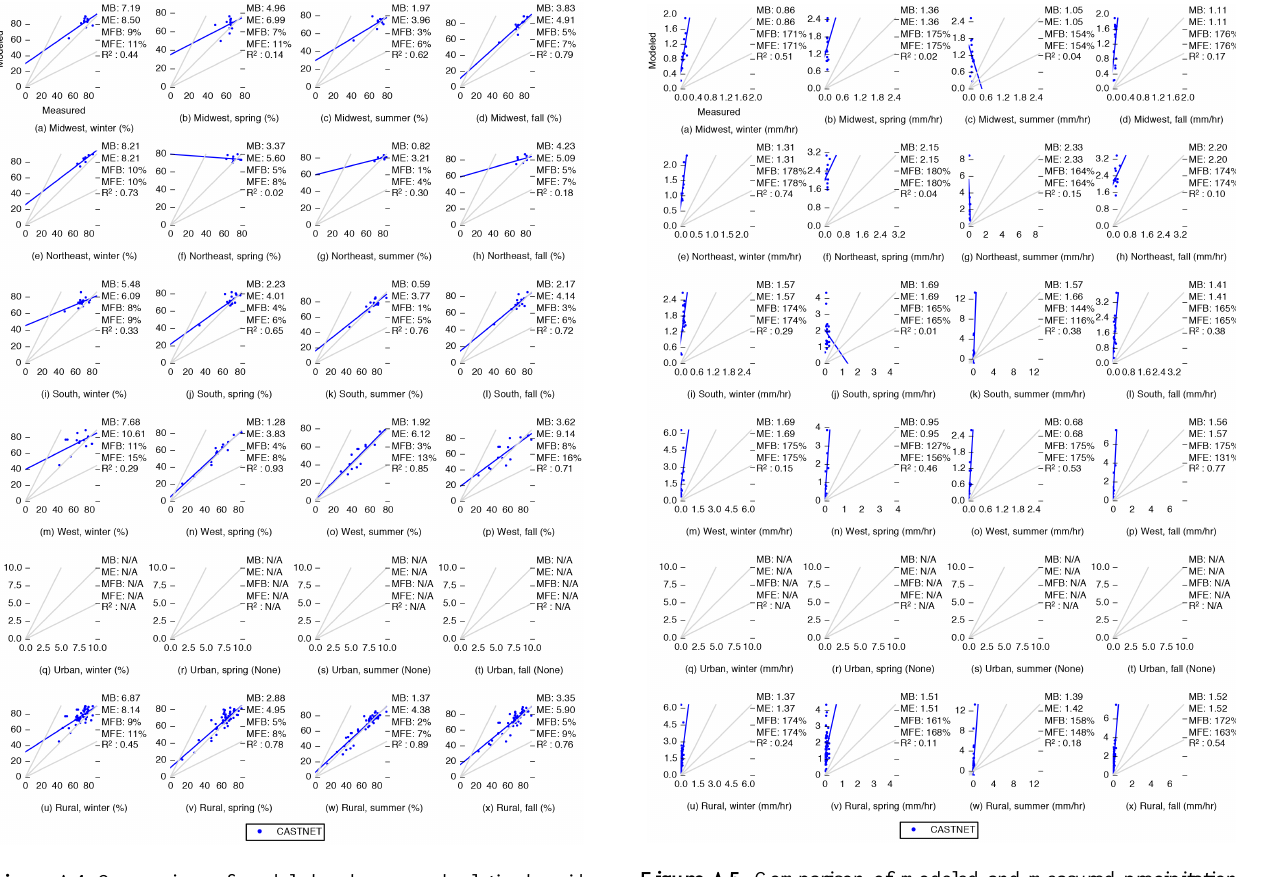
Figure A4. Comparison of modeled and measured relative humid- ity, disaggregated by region and season.